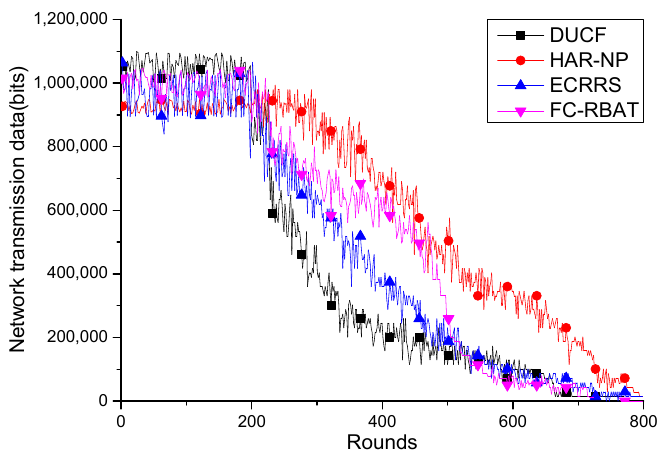
Figure 9. Comparison of network transmission data.